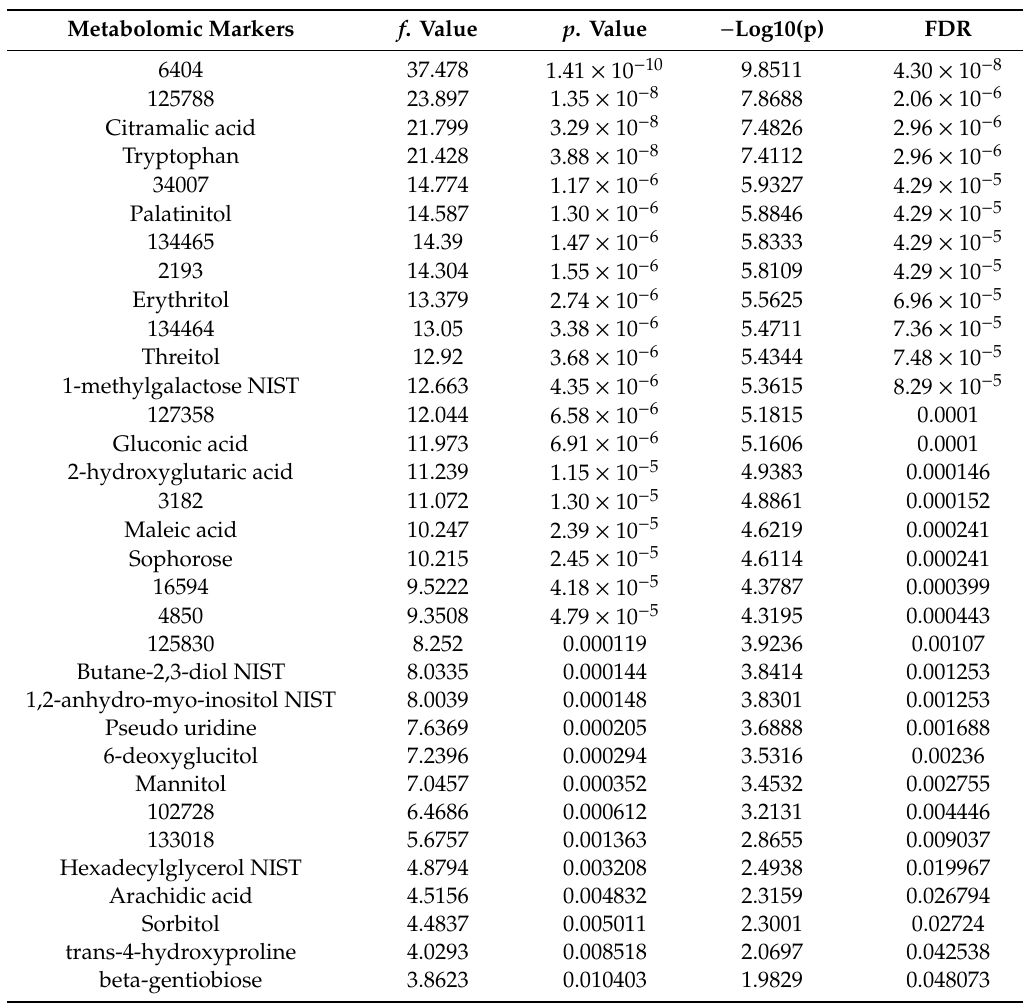
Table 1. Metabolomic markers that could be used to di ff erentiate ‘Java / Kouilou’ from ‘Niaouli’ genotypes as detected by one-way ANOVA and post-hoc analyses ( f > 4.0; p < 0.01; − Log 10 ( p ) > 2.0; FDR < 0.05). Fisher’s LSD identified ‘Java / Kouilou’ to be higher in content in the metabolites listed here compared to ‘Niaouli.’ The f -value is derived from the F -statistic test for significance, the p -value is used to test variability between two groups, − LOG 10 ( p ) determines the significant levels, such as *, **. and ***. The False discovery rate (FDR) assists in testing significant result from p